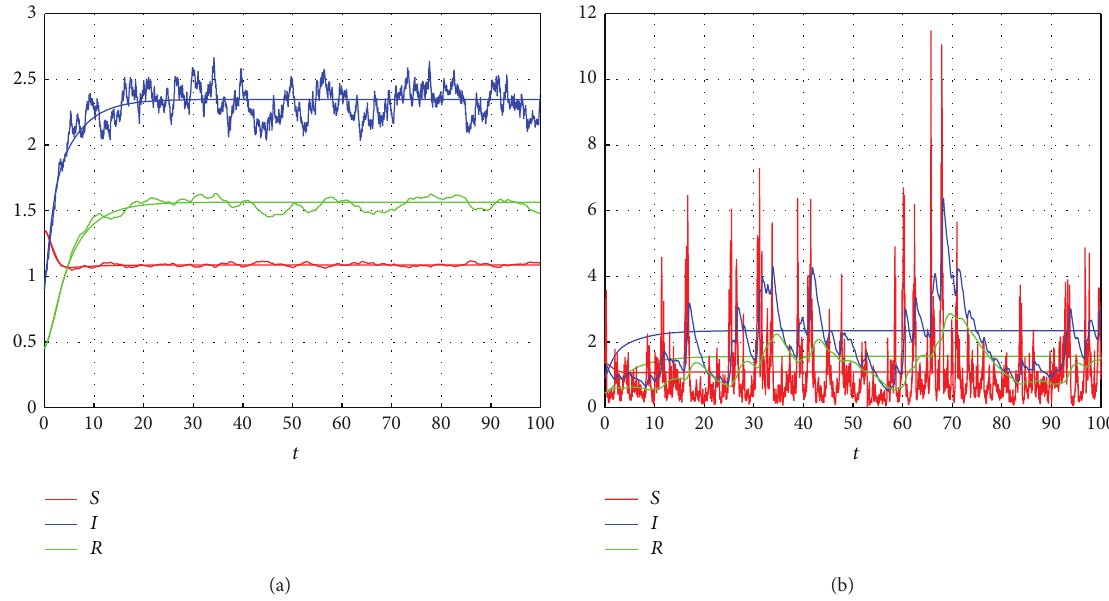
Figure 2: Solutions of model (3) with different noise. Other parameters and initial condition are the same as Figure 1. (a) 𝜎 1 = 0 , 𝜎 2 = 0.06 , and 𝜎 3 = 0 and (b) 𝜎 1 = 1.7 and 𝜎 2 = 𝜎 3 = 0